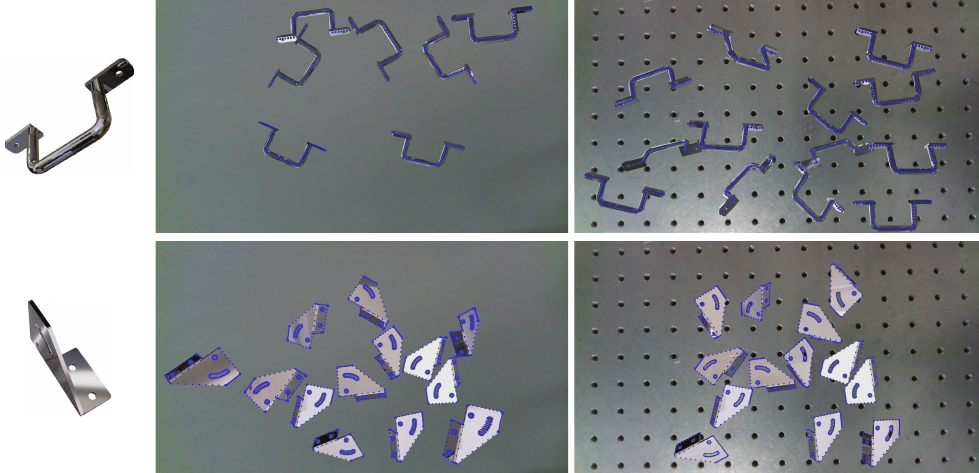
Figure 6. The figure illustrates the results of labeling keypoints. The first column is the metal model, the second and third columns are the synthesis images with keypoints. The blue dots are the marked